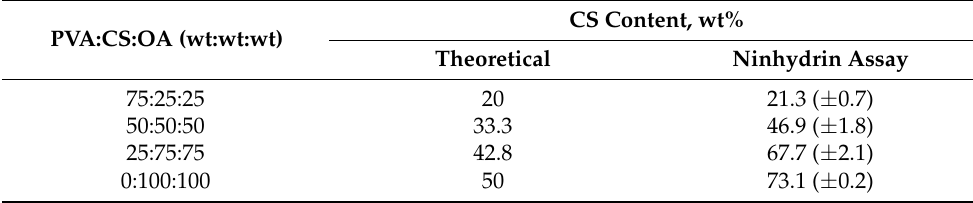
Table 2. The content of CS in hydrogels with different PVA:CS:OA ratio.